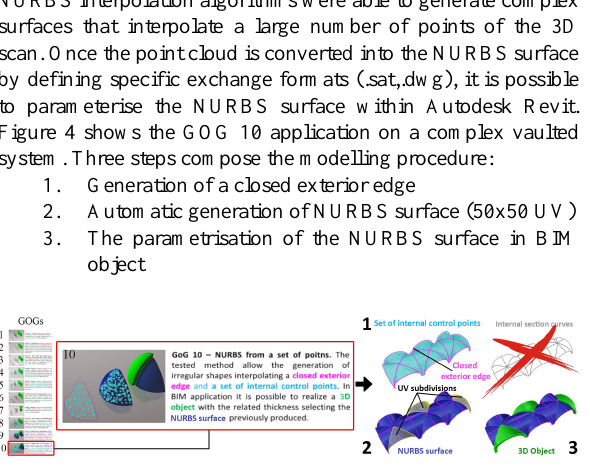
Figure 4. GOG 10 allowed the generation of any vault with a GOA of 1 mm from the 3D scan (1), the automatic generation of the 3D objects (3) from a NURBS model (2) in